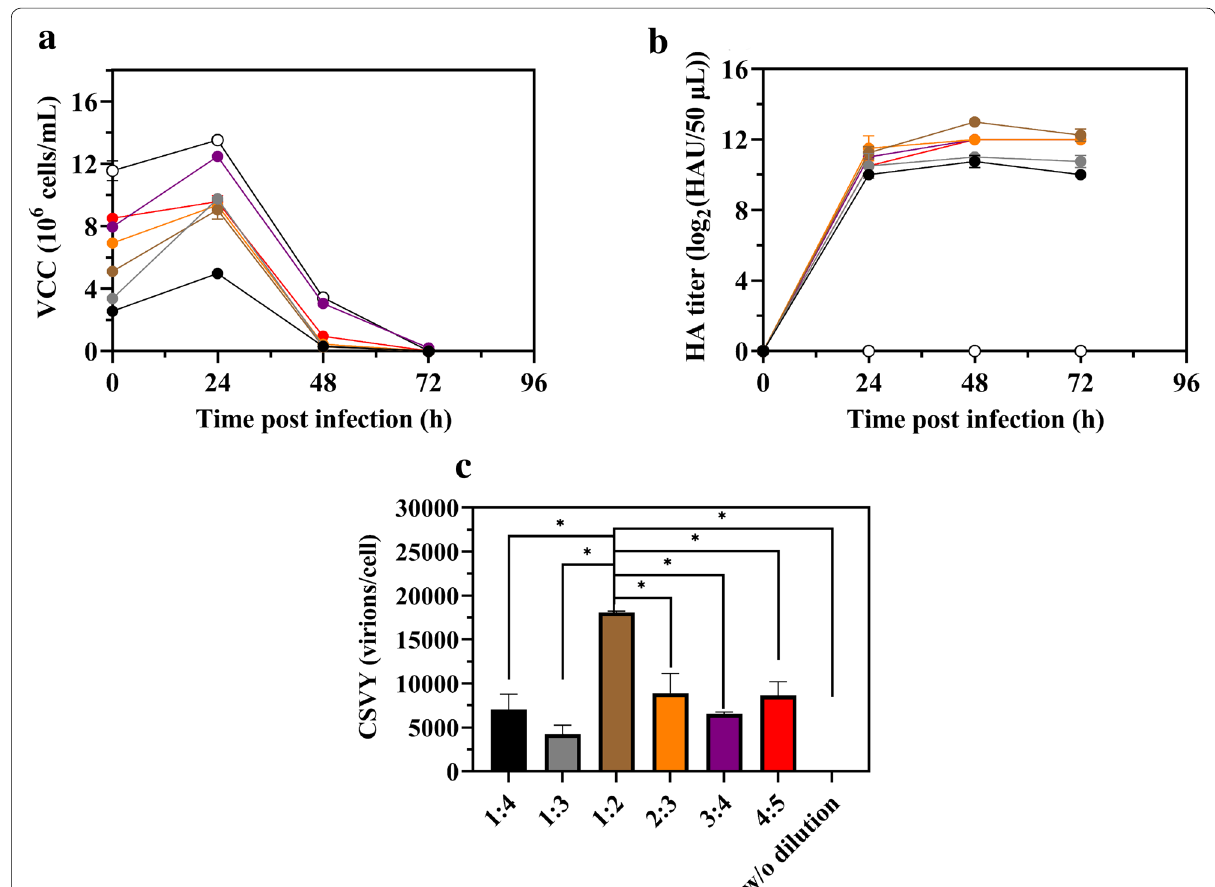
Fig. 4 MDCK cell growth and H9N2 virus production with various feed strategies at TOI in shake flasks ( n b HA titers in the infection phase. c The corresponding cell‑specific virus yield. Medium dilution: 1:4 (black), 1:3 (gray), 1:2 (brown), 2:3 (orange), 3:4 (purple), 4:5 (red), and w/o dilution